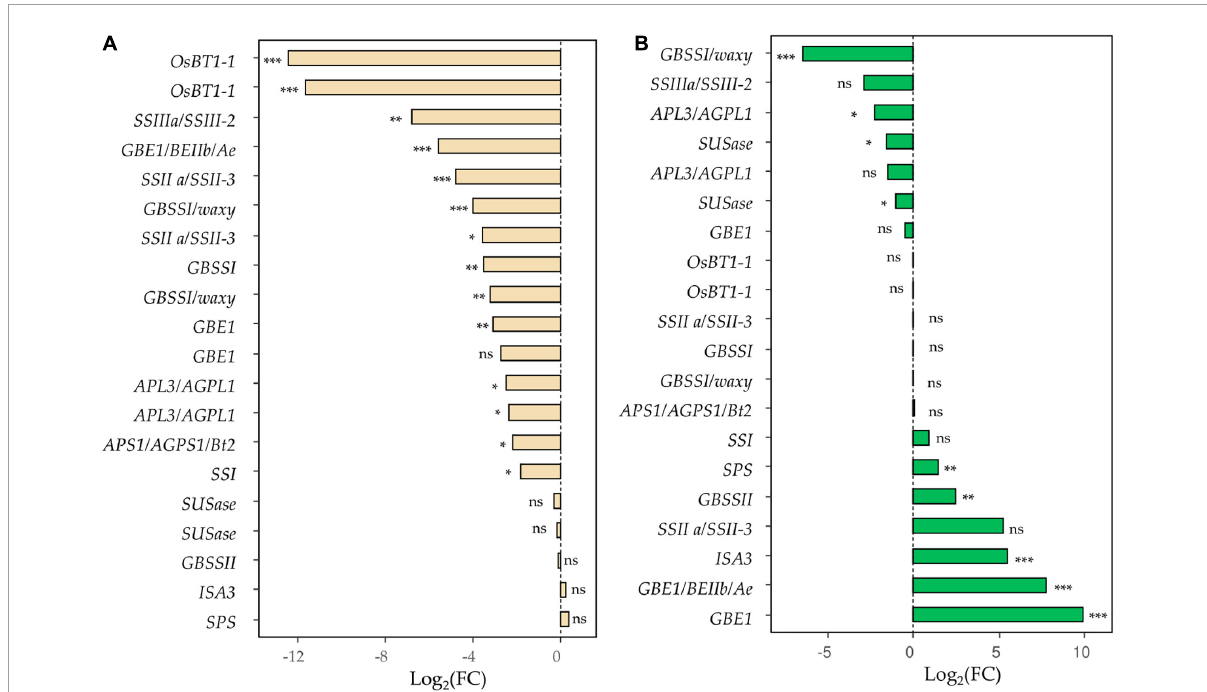
FIGURE3 Starch synthesis-related genes (SSRGs) differentially expressed (DE) in (A) grain and/or (B) leaf tissue for the pair-wise comparison wild type (WT) vs. E82. *, FDR < 0.05; **, FDR < 0.01; ***, FDR < 0.001; ns, non-significant; FDR, False Discovery